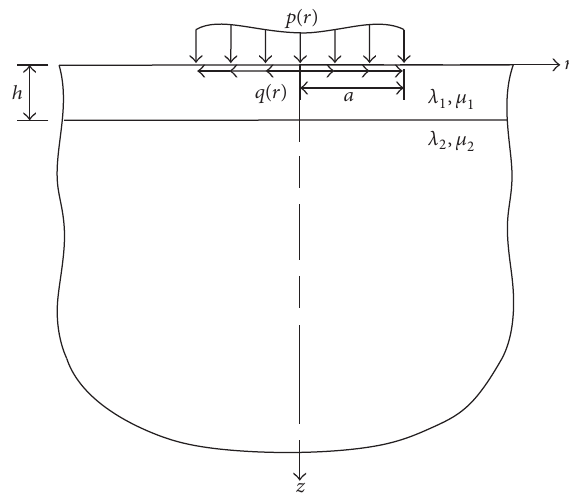
Figure 1: Layered elastic half space subjected to axisymmetric surface